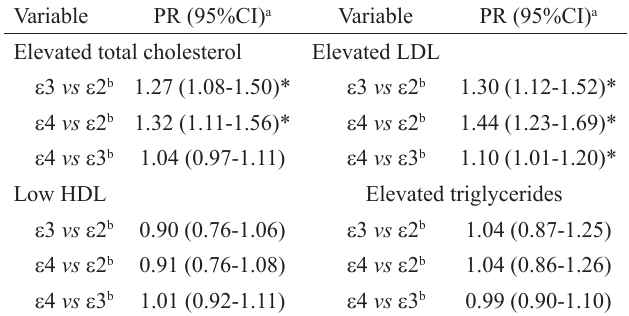
Table 2. Association between APOE alleles and elevated serum